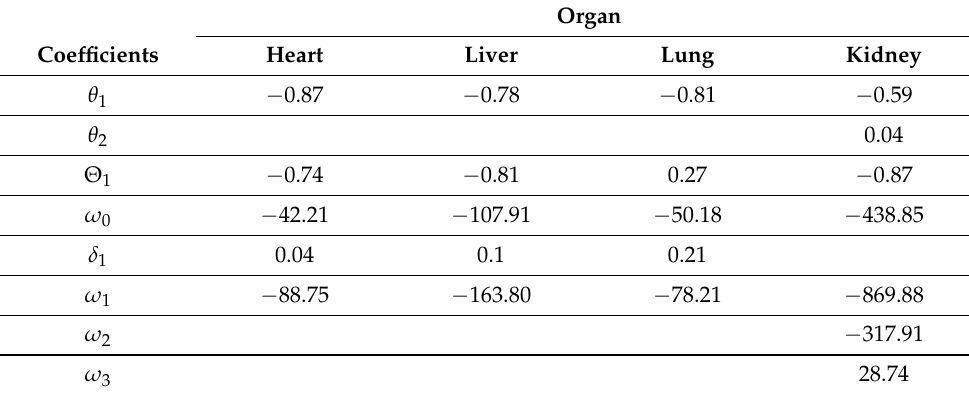
Table A2. ITSA model parameter estimates for